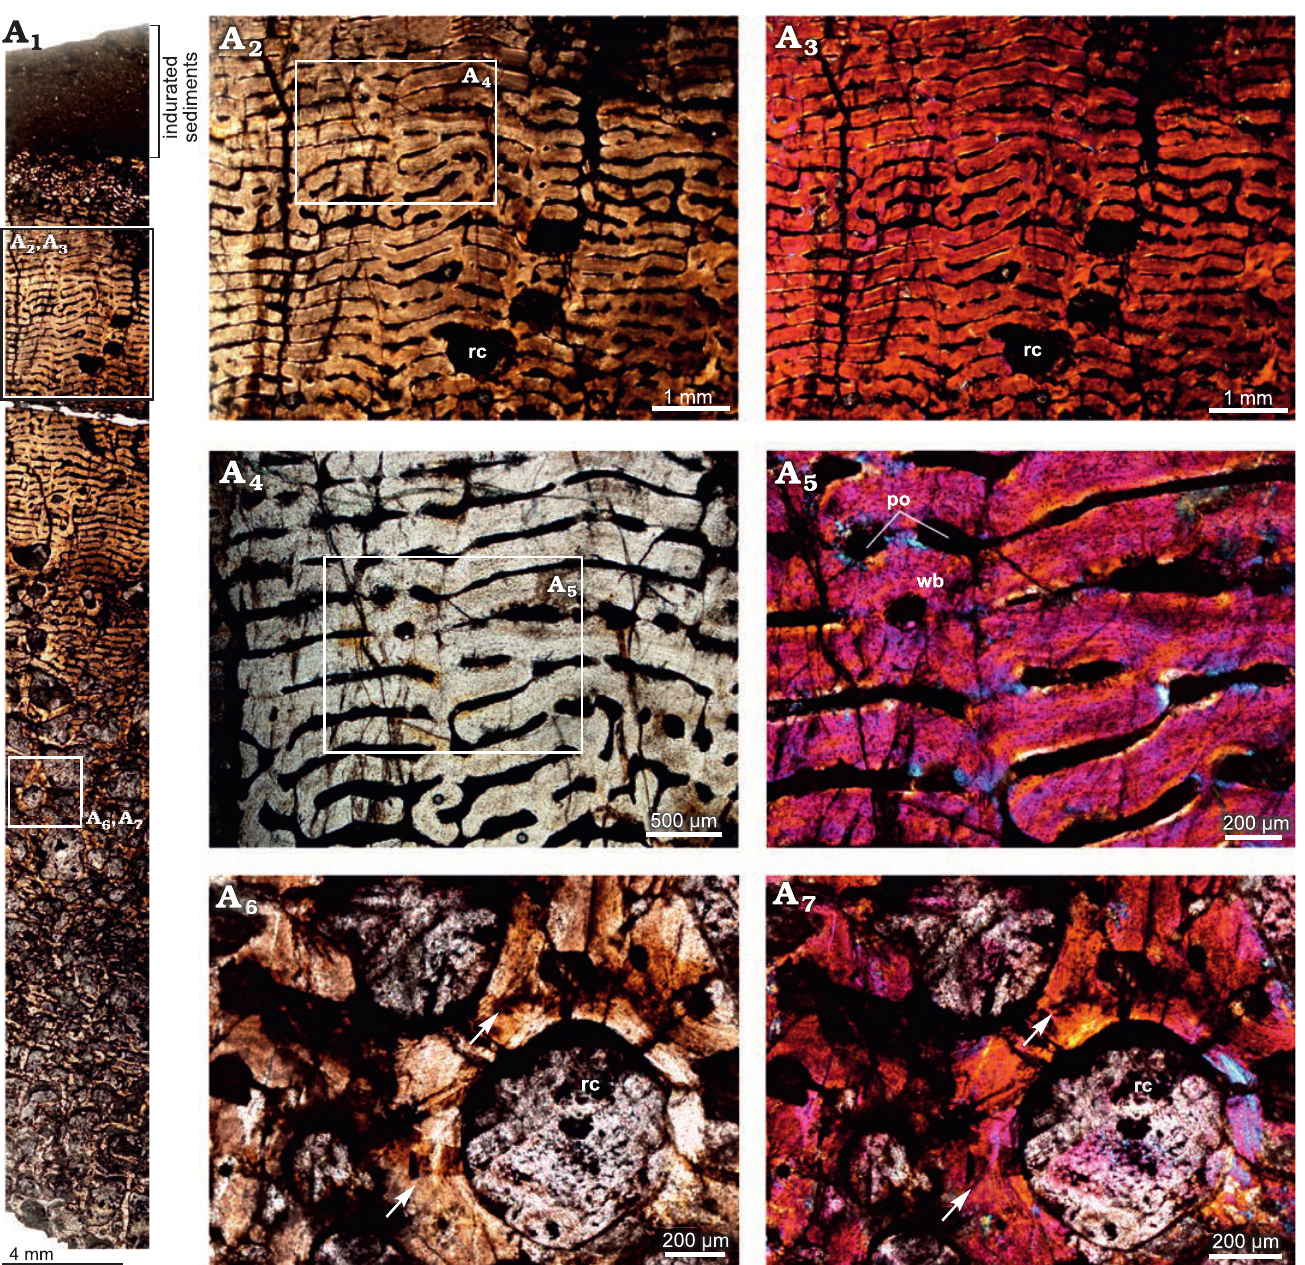
Fig. 4. Thin section of a core of the humerus (SAM-PK-11994) of Jonkeria ingens (Broom, 1923) from the middle Permian Tapinocephalus Assemblage Zone of the Karoo Basin of South Africa. A 1 , overall view of humerus showing laminar fibrolamellar bone in the outer cortex and the increasingly cancel- lous nature of the bone towards the medullary cavity; note: numerous enlarged resorption cavities in the perimedullary cavity, and the layer of indurated sediments at the top of the section. A 2 , A 3 , highly vascularized laminar fibrolamellar bone. A 4 , A 5 , details showing a few isolated simple longitudinal vascular canals and primary osteons. A 6 , A 7 , detail showing large resorption cavities lined by narrow deposit of lamellar bone (arrows). Abbreviations: po, primary osteons; rc, resorption cavity; wb, woven bone. Photographs under ordinary light (A 1 , A 2 , A 4 , A 6 ), and cross-polarized light with lambda compensator (A 3 , A 5 , A 7